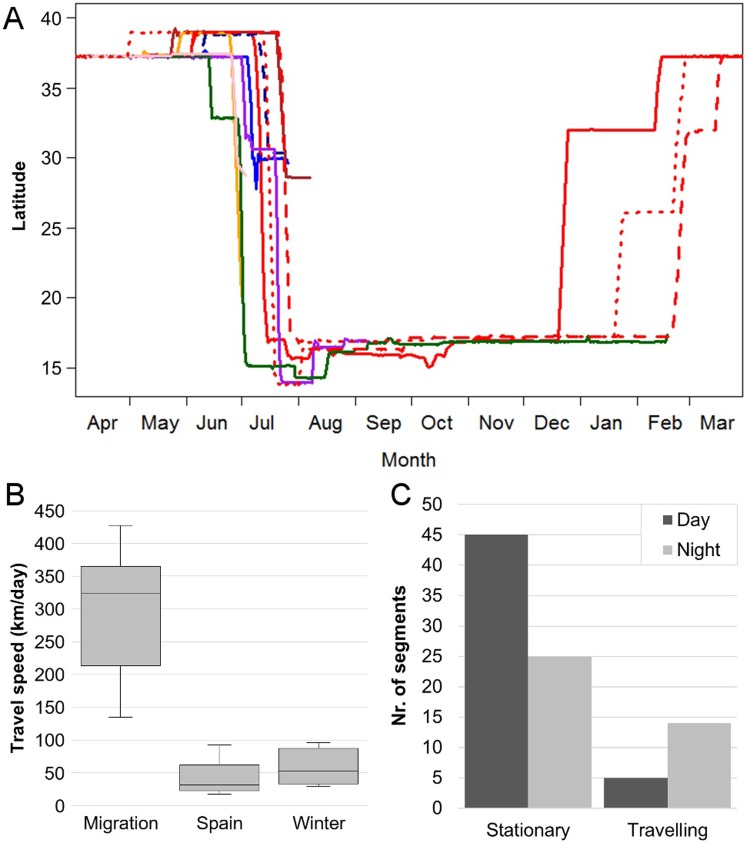
Migratory strategy.(A) Individual tracks of eight migratory great spotted cuckoos for latitude versus time. Colors correspond to individual cuckoos, line types correspond to different years (2013: dash, 2014: solid, 2015: dotted). Some birds travel north from the breeding area before initiating migration. Stopover sites in Morocco and wintering areas in sub-Saharan Africa can be distinguished. (B) Travel speed between locations within different regions. Boxplots show the median, first and third quartile ("hinges") and the minimum and maximum values ("notches"). (C) Total numbers of travel segments collected during migration classified as either stationary or travelling (speed of >5 km/h), occurring during either day or night. While the total number of travelling segments was lower than that of stationary segments, there were significantly more travelling segments recorded during the night.